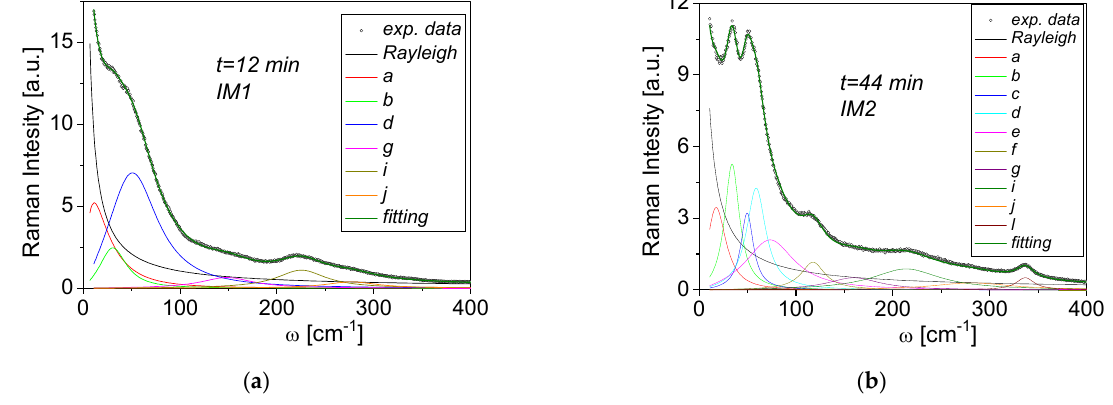
Figure 5. Examples of Raman spectra fitting correspond on a timescale to the ( a ) IM1 phase and ( b ) IM2 phase.